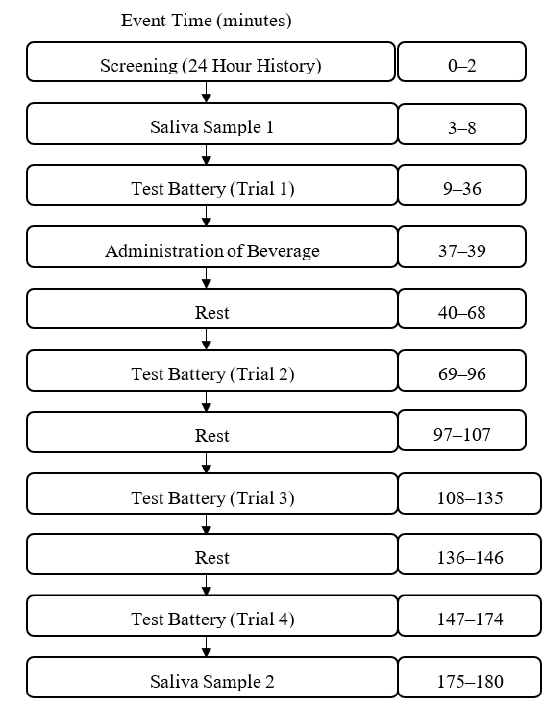
Figure 1. Test day process flow diagram.